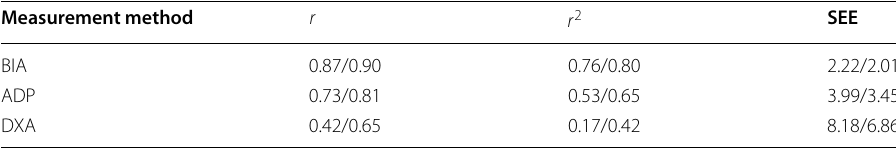
Table 12 Data heterogeneity among multiple